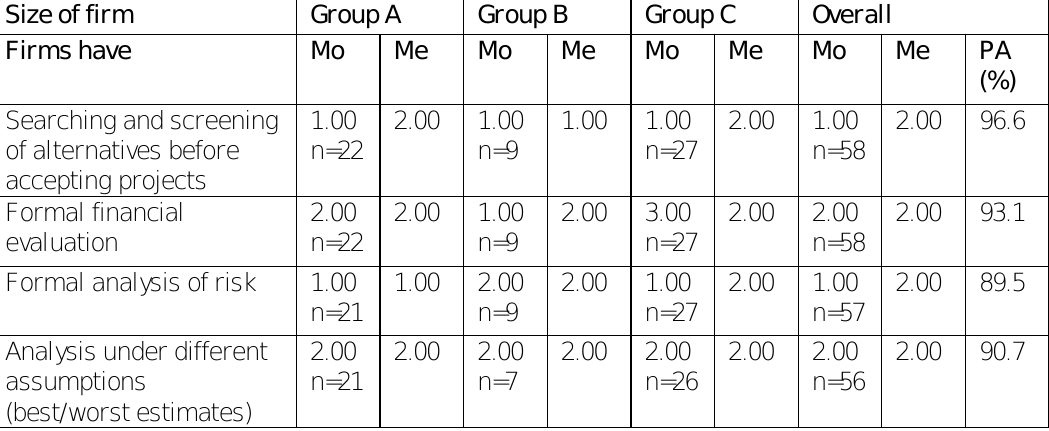
Table 1: Comparisons of the usage of capital budget evaluation